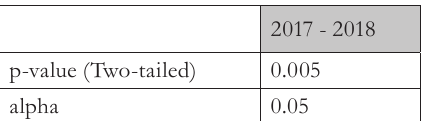
Tab. 6 – Table results: Fisher’s exact test with alpha 0,05. Source: own research using question-